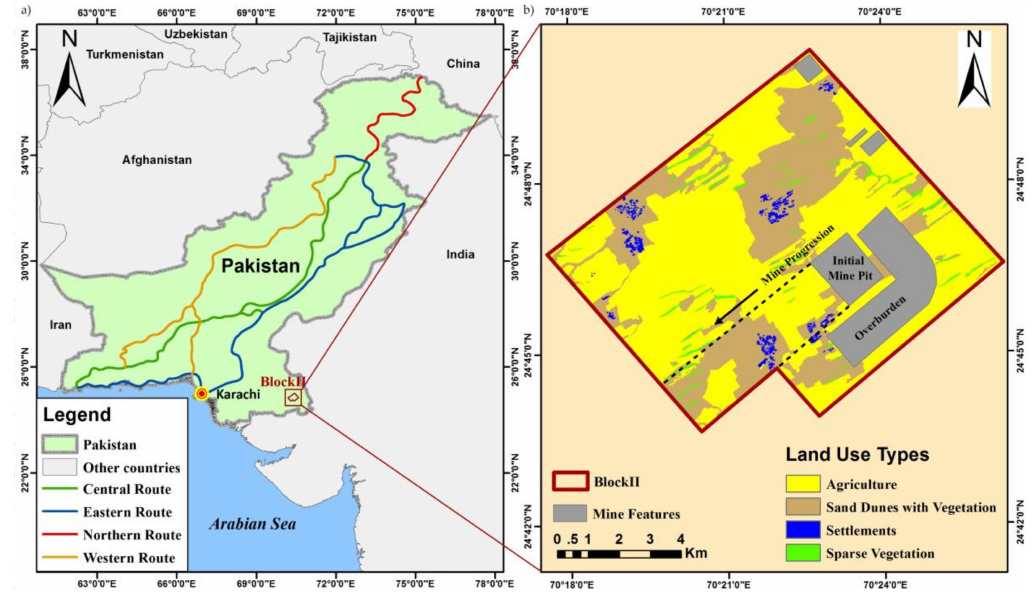
Figure 2. ( a ) Map of Pakistan, Central, Eastern, Northern, and Western routes of CPEC; ( b ) the Study area of coal mining project under assessment (block